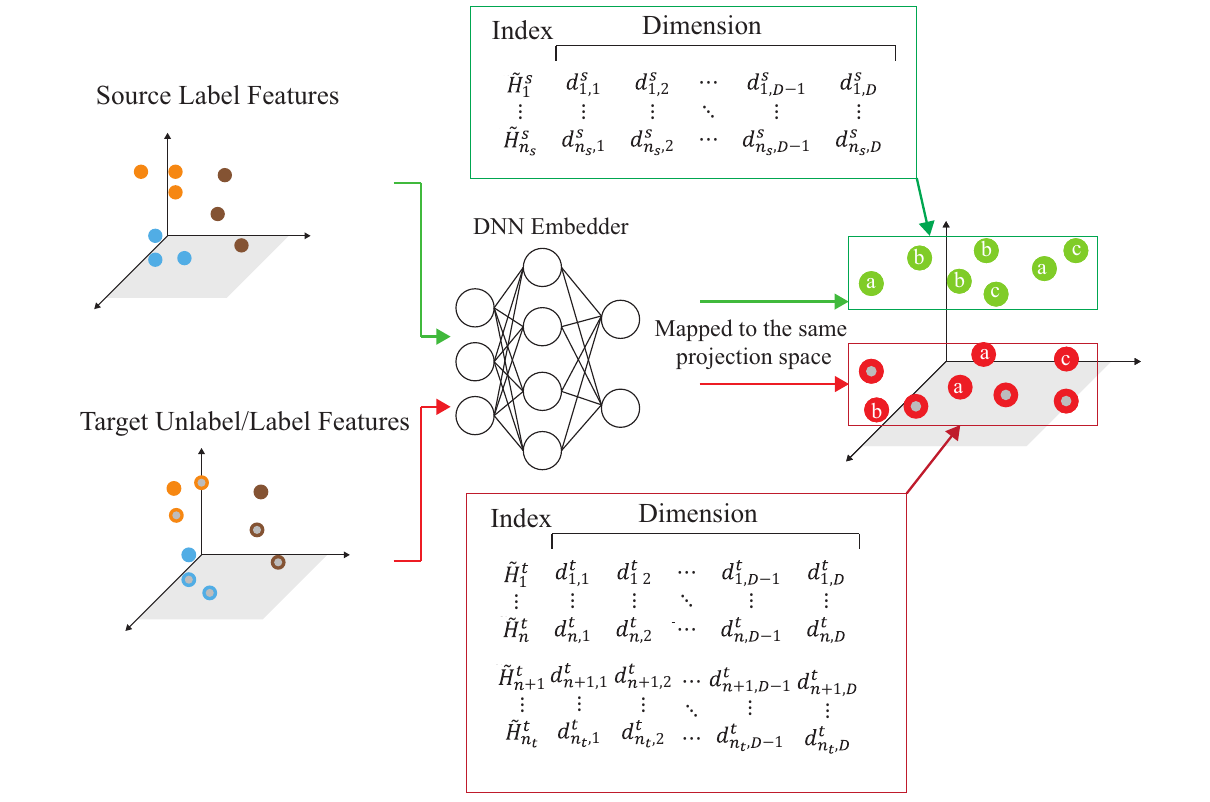
Figure 11. The mapping process to a projection space.